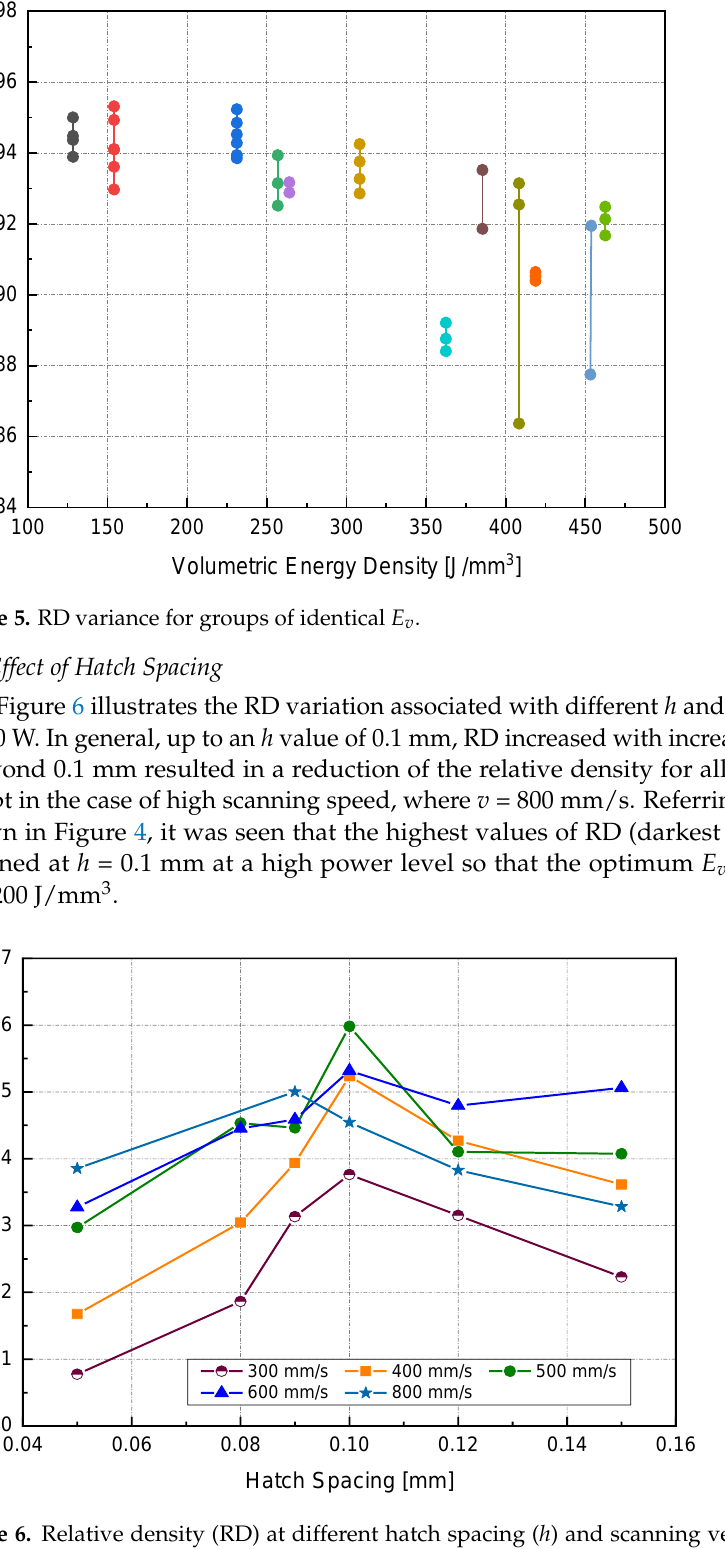
Figure 6. Relative density (RD) at different hatch spacing ( h ) and scanning velocity using a laser power of 370 W.